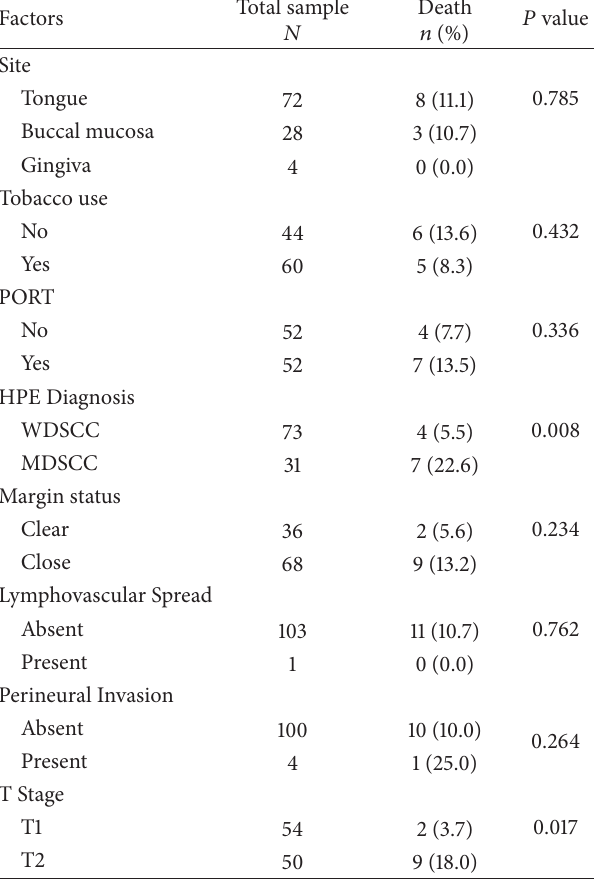
Table 2: Univariate analysis of factors associated with survival. Table 3: Cox regression analysis for risk of mortality in the studied patients.